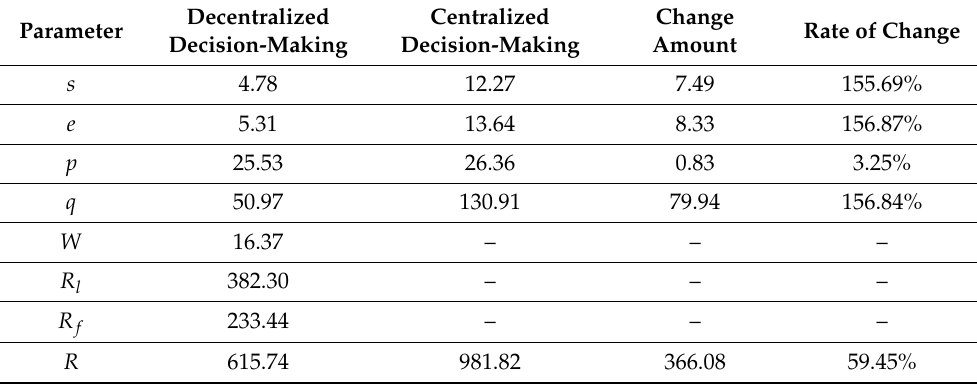
Table 7. The optimal decisions and profits of two decision models without government subsidies. Parameter